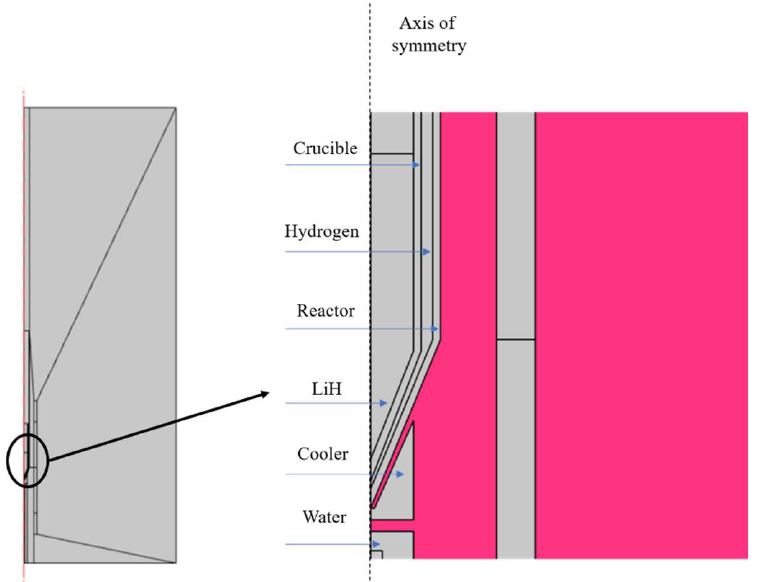
Figure 3. Two-dimensional axisymmetric geometry diagram for LiH single crystal growth device.